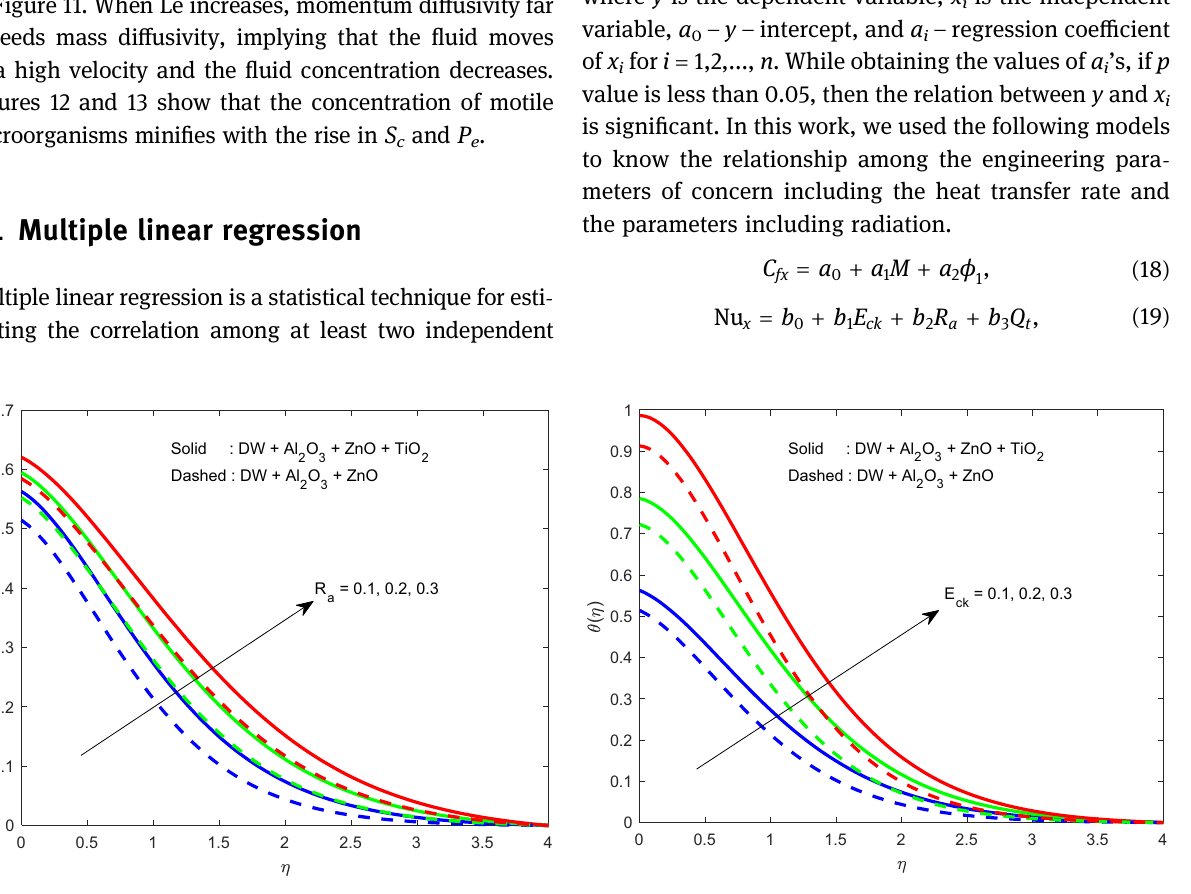
Figure 7: Increasing e ff ects of ϕ 1 on θ ( η ) .